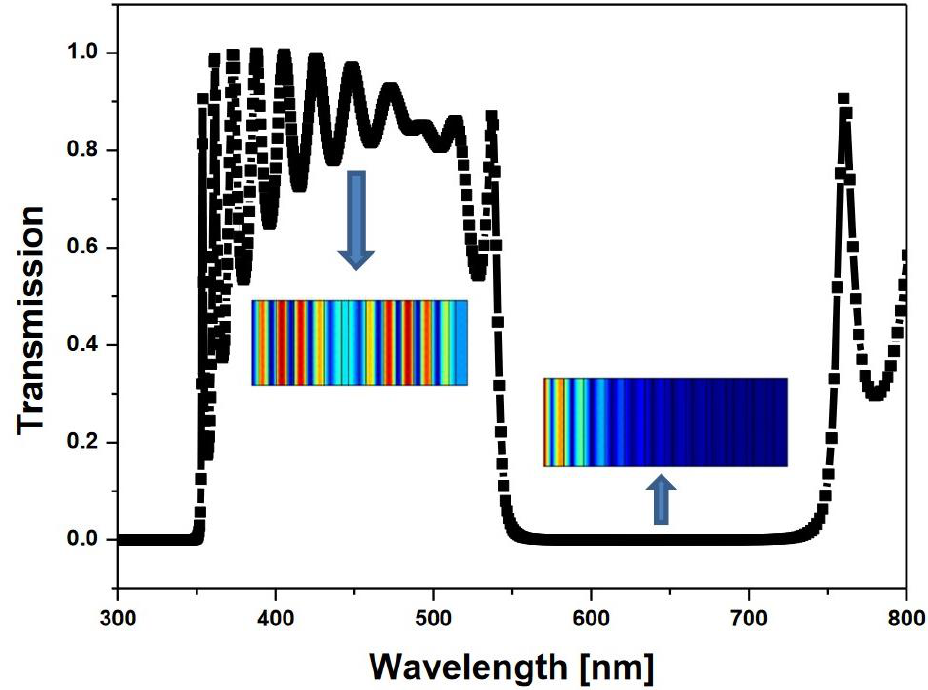
Figure 6. Transmission spectrum for one-dimensional photonic crystals composed of silicon dioxide and silicon, with thicknesses of 40 nm and 75 nm, respectively. The number of periods equals 12.